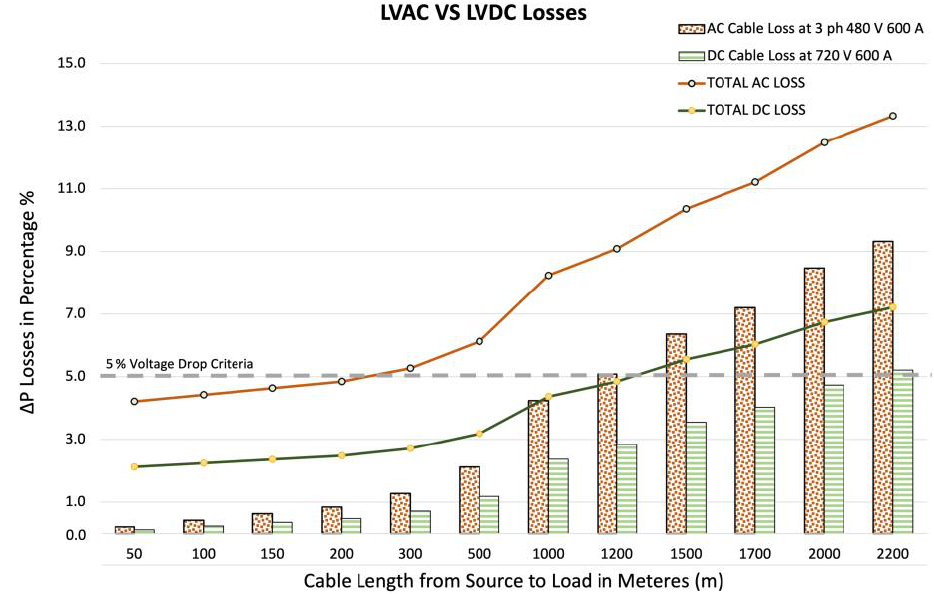
Figure 9. Three-phase LVAC vs. bipolar LVDC distribution losses with respect to cable distance for maximum Type #1 charging station hourly EV load profile.